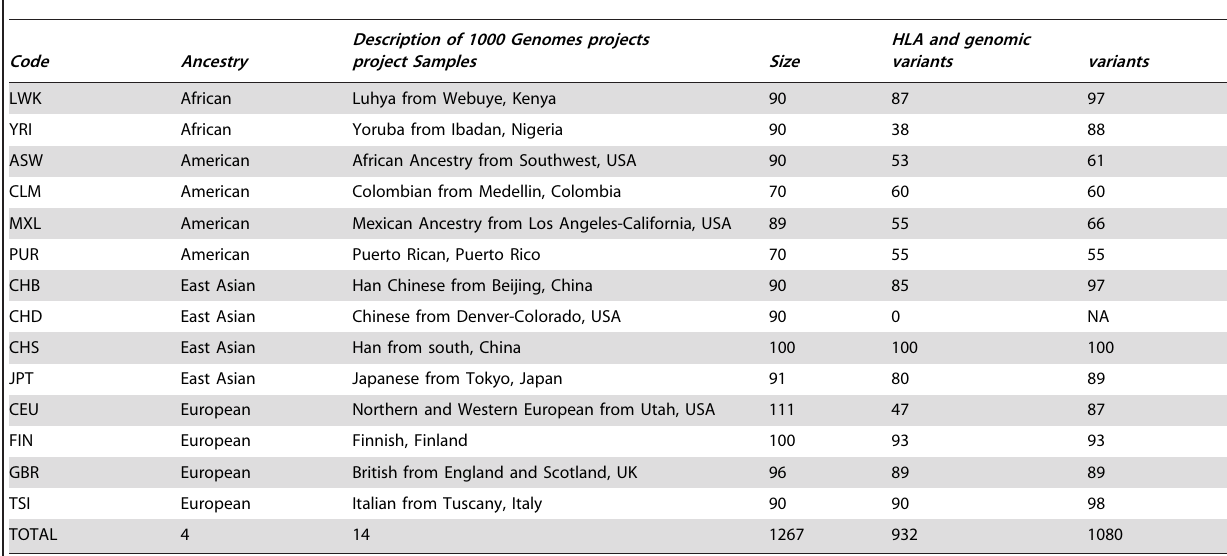
Table 1. Overview of the 1000 Genomes project samples typed for HLA